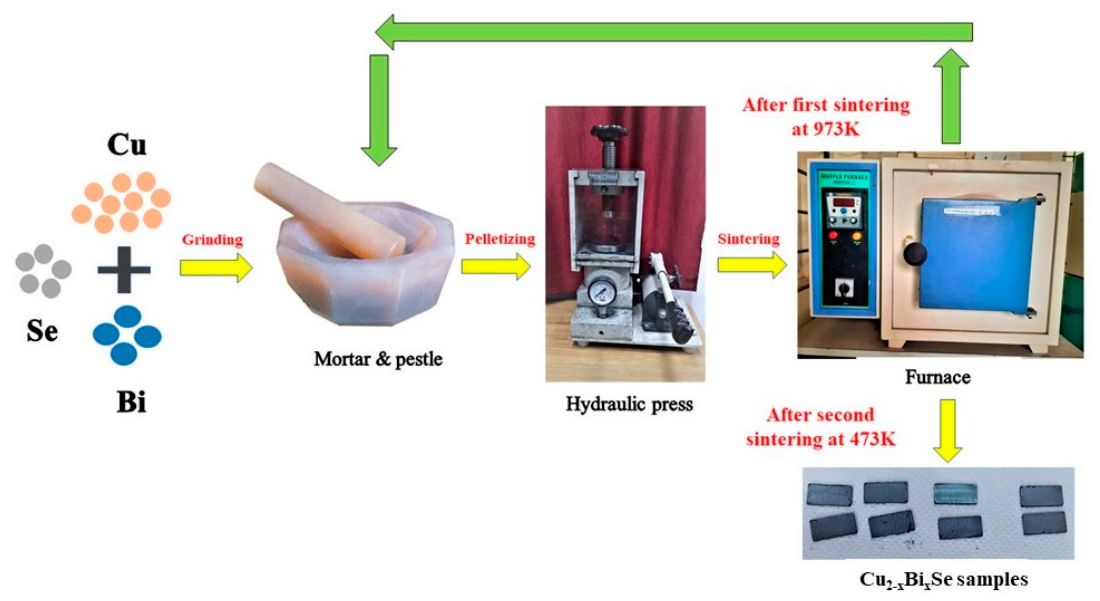
Figure 1. Schematic representing the synthesis process of Cu 2 − x Bi x Se samples.